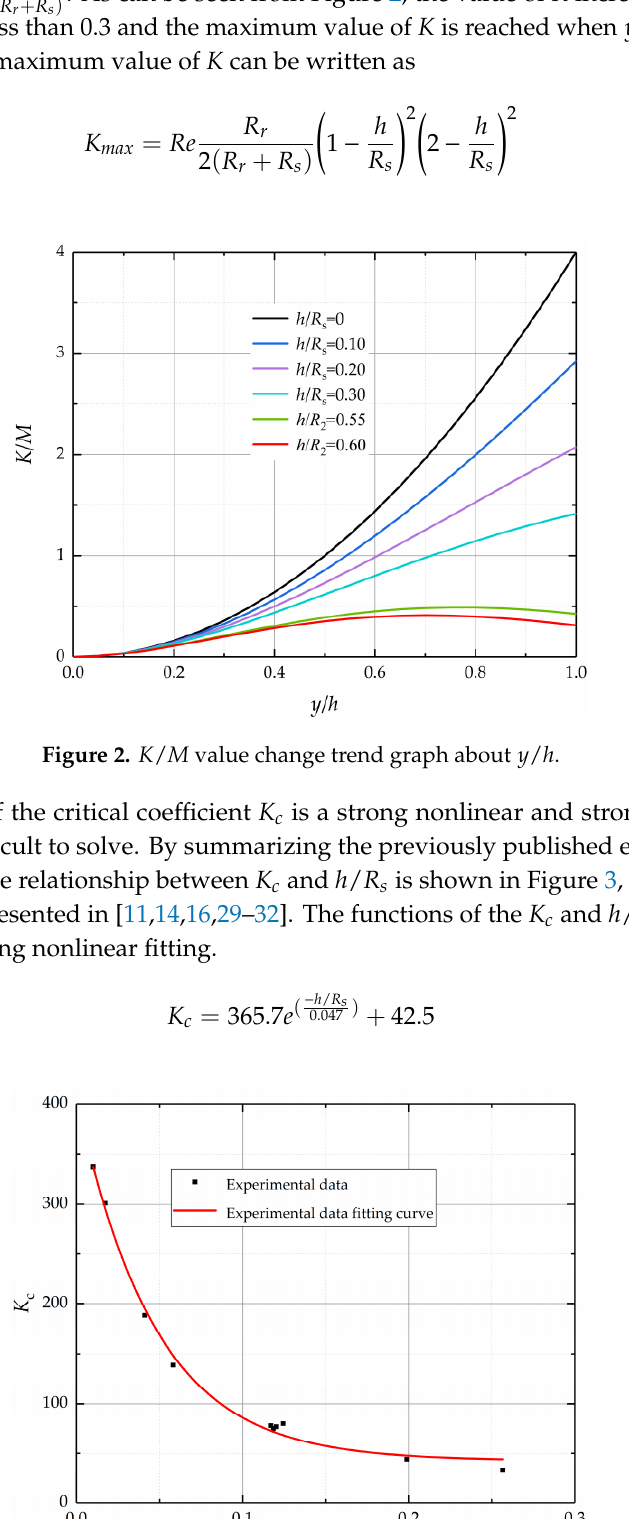
/ h R . Figure 3. The critical coe ffi cient K c value change trend graph about h / R s s / h R . s